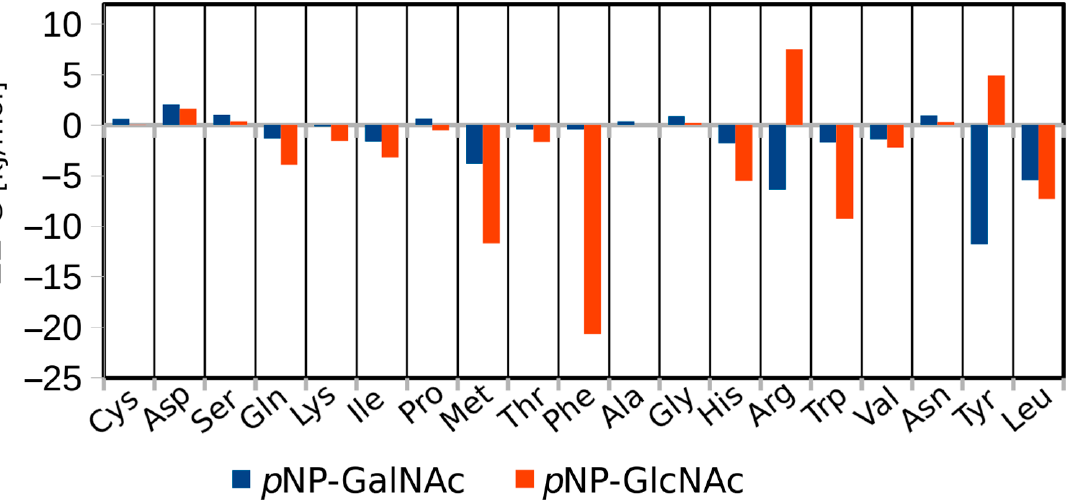
Figure 2. Change in the free energy of binding ( ∆∆ G ) of the enzyme-substrate complex compared to the WT enzyme ( ∆∆ G WT = 0 kJ/mol). Change in GlcNAcase activity (affinity to p NP-GlcNAc) is shown in orange, and change in GalNAcase activity (affinity to p NP-GalNAc) is in blue.